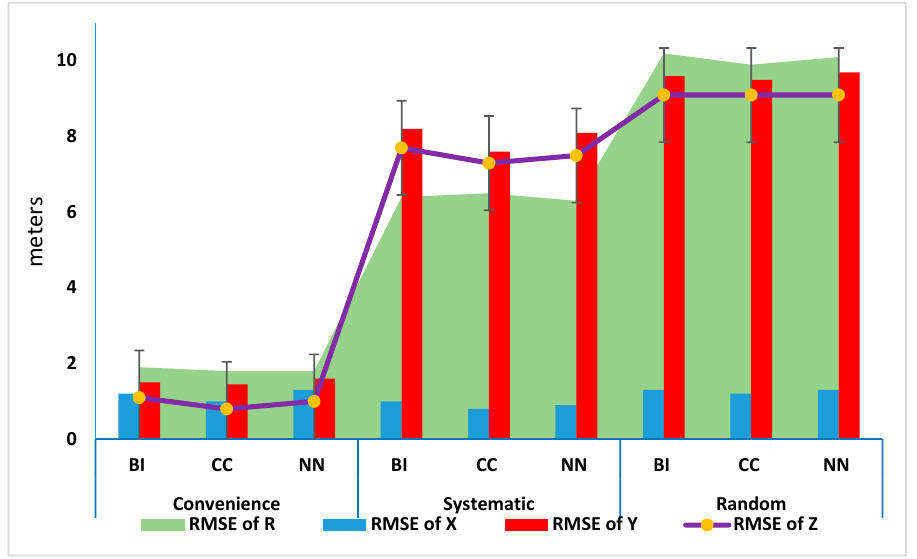
Figure 4. Horizontal and vertical errors associated with all resampling methods and their GCP collection pattern.